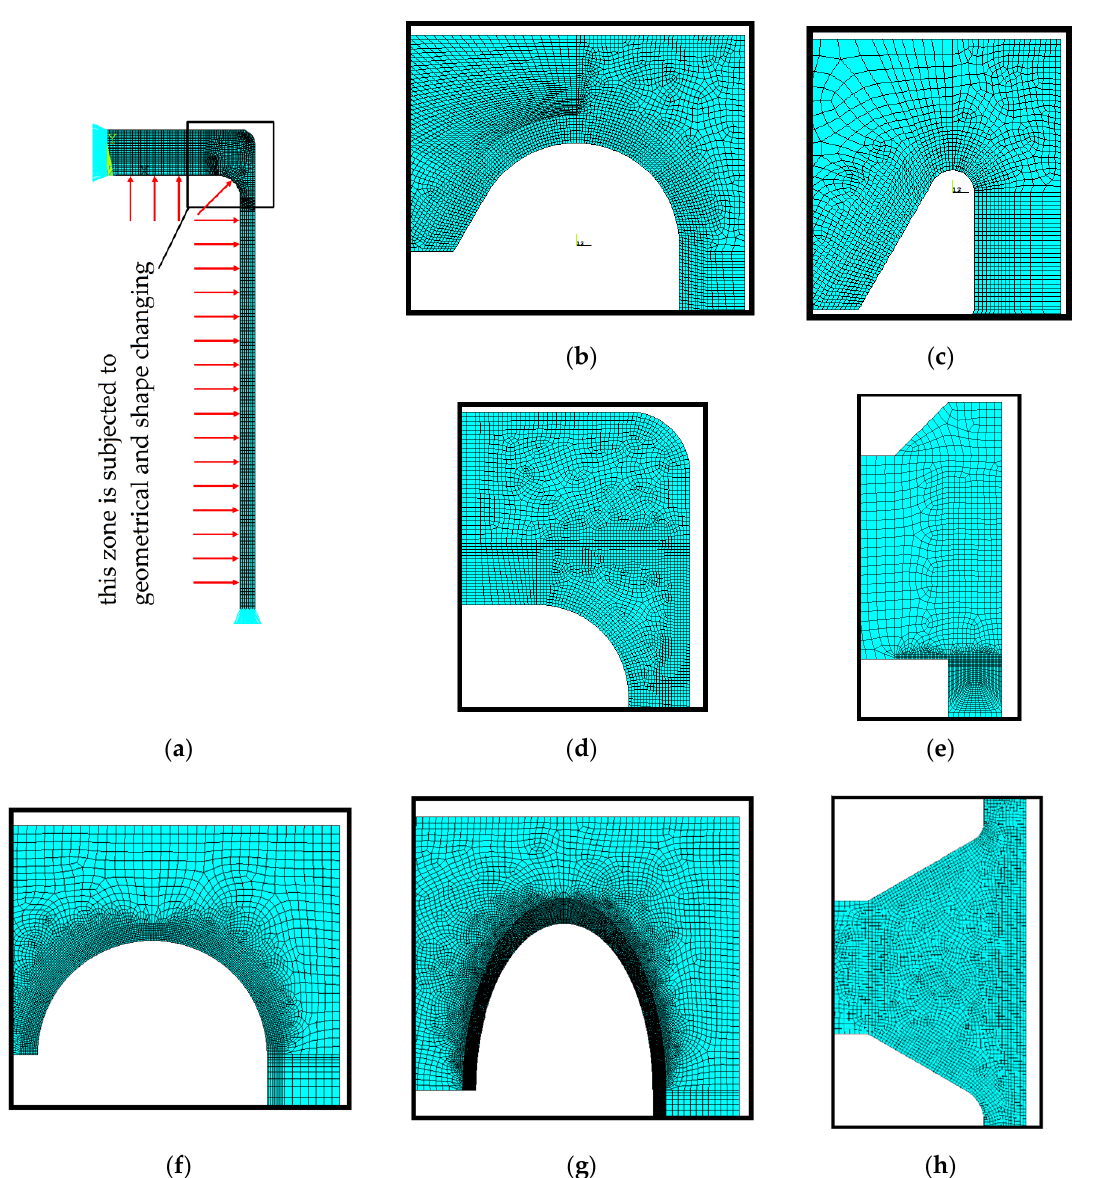
Figure 9. Numerical models for analyses of pressure vessels with flat heads: ( a ) finite element mesh with boundary conditions; ( b ) mesh for experimentally tested endplate type “e” with optimal SRG; ( c ) mesh for experimentally tested endplate type “e” with non-optimal SRG; ( d ) mesh for endplate type “a”; ( e ) mesh for endplate type “d”; ( f ) mesh for endplate type “f”; ( g ) mesh for proposed elliptical SRG; ( h ) mesh for endplate type “h”.